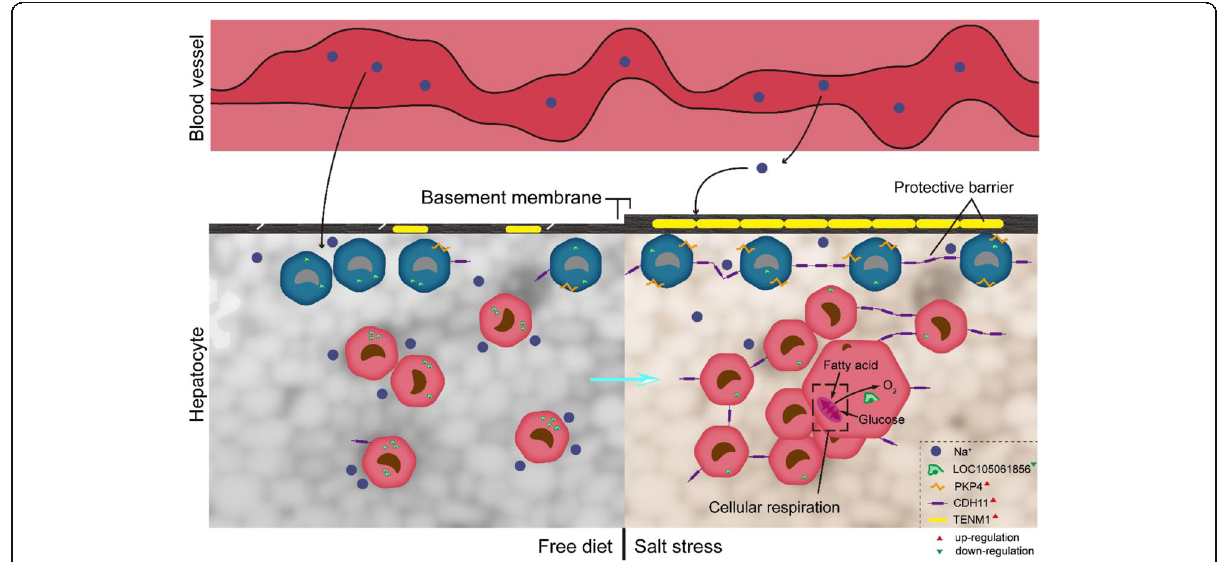
Fig. 6 Advanced protective barrier and sodium ion homeostasis, and reduced aerobic respiration contributing on salt resistance in camel